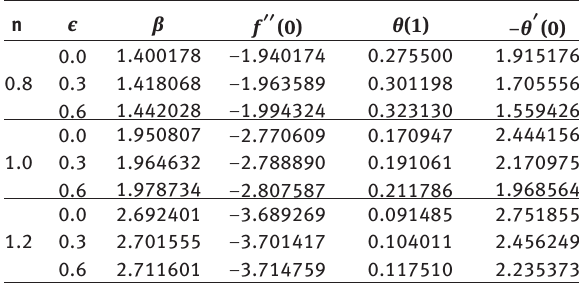
(cid:2) (0) for different values of